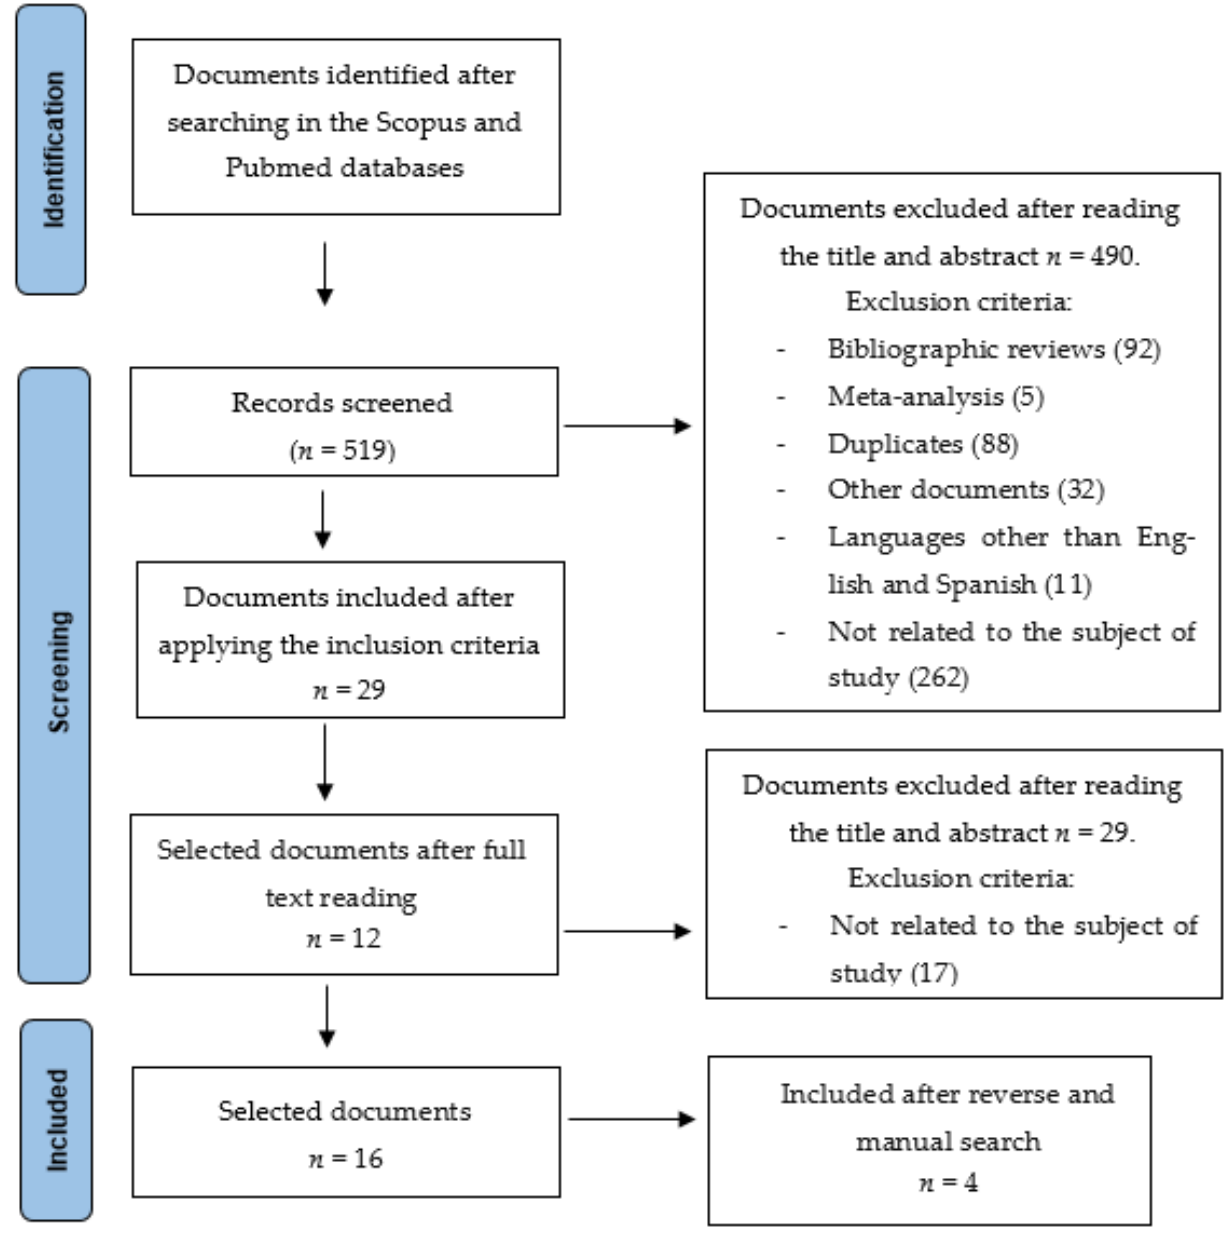
Figure 1. Selection process for reviewed articles.